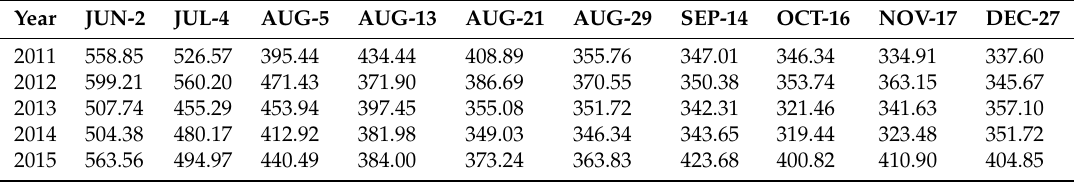
Table 3. Model performance of the convolutional neural network (CNN) measured in RMSE,